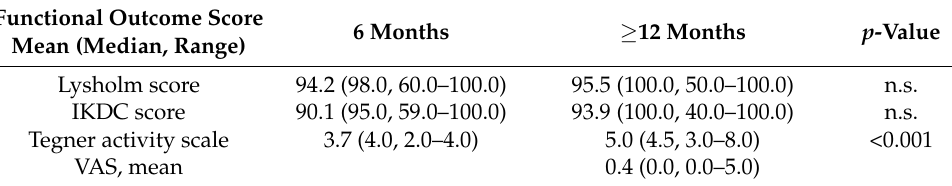
Table 3. Functional outcome